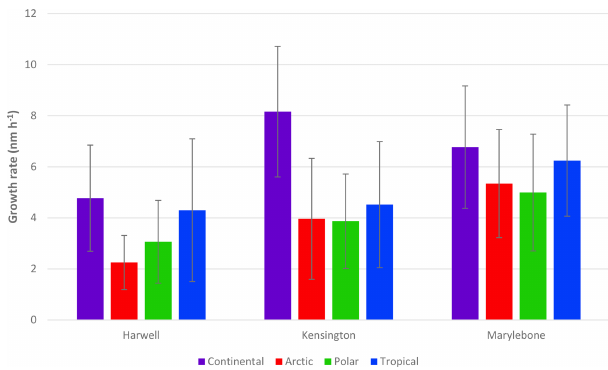
Figure 6. Growth rate per incoming air mass origin at each of the sites.